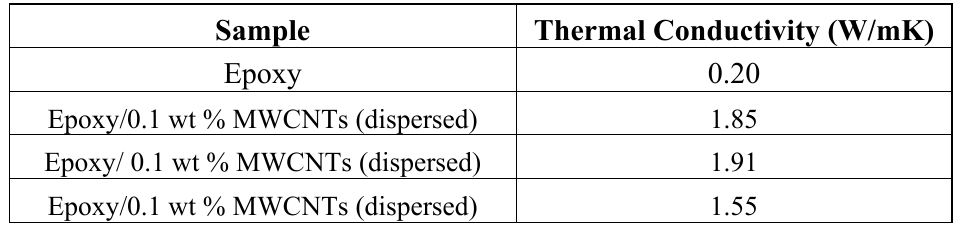
Table 5. Thermal Conductivity of Epoxy/MWCNTs